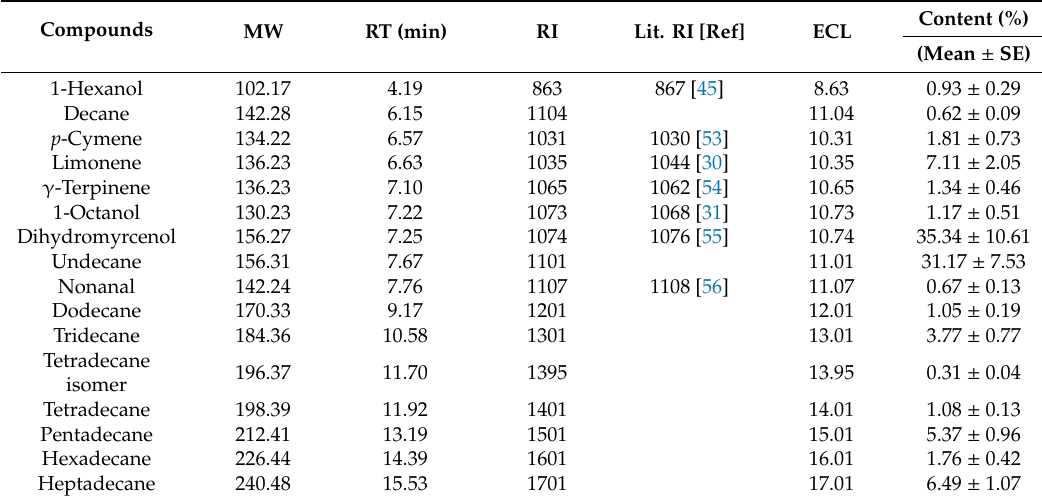
Table 5. Headspace volatile compounds emitted by workers of Oecophylla smaragdina.